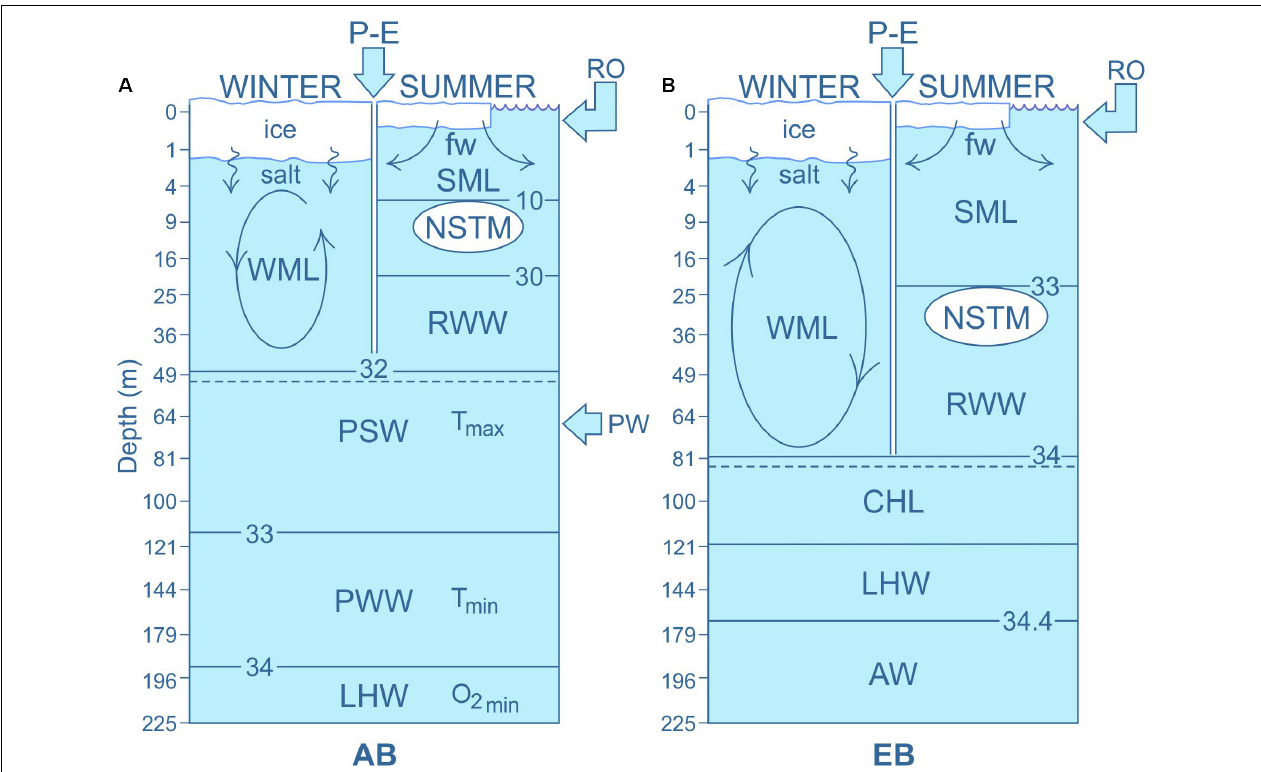
FIGURE 2 | The Arctic Ocean’s two “lids”: sea ice and the halocline. Sea ice growth in winter adds salt to the surface ocean, driving penetrative convection to form the winter mixed layer (WML). In summer, freshwater (FW) is added to the mixed layer through seasonal contributions of sea ice melt, terrestrial runoff (RO) and the balance of precipitation-evaporation (P-E), which strongly stratify the surface ocean. This stratification limits the depth of wind mixing, allowing formation of a shallow summer mixed layer (SML). Below the SML, fractions of the previous season’s processes may remain; specifically, a cool remnant winter water (RWW) immediately above the base of the WML from the previous year. In the presence of sea ice with sufficient open water, a near-surface temperature maximum (NSTM) may form immediately below the SML by solar heating, capped by the cold, low salinity surface layer. These exchanges between the surface ocean layer and the sea ice “lid” occur across the Arctic Ocean, however, the additional FW associated with Pacific water (PW) enhances surface stratification in the Amerasian Basin (AB) and contributes to the difference between the halocline “lid” within the deep AB and that of the Eurasian Basin (EB); represented conceptually in (A,B) , respectively. In both the Pacific and Atlantic sectors of the Arctic Ocean, warm Atlantic-derived waters (AW) form the base of the halocline. The water column above is comprised of multiple layers that define the seasonal and permanent haloclines, constrained by the horizontal interleaving of seasonally modified FW inputs. (A) In the Pacific sector halocline, PW inputs from the Bering Sea interflow, increasing stratification, and further constraining the depth of convection. Here, the winter convection penetrates down to the base of the Pacific Summer Water (PSW) and the sub-surface temperature maximum (Tmax), which in turn lies above the Pacific Winter Water (PWW) and the sub-surface temperature minimum (Tmin). Below PW lies lower halocline water (LHW), which likely forms on Siberian shelves. (B) In the Atlantic sector, the thickness and distribution of halocline layers is highly variable across the EB, but includes a cold halocline layer (CHL) and LHW layer above the warm AW layer. Both form as a consequence of sea ice formation and winter convective mixing events; CHL mostly within the basin and LHW on mostly on shelves with subsequent drainage into the basins (after Aagaard et al., 1981; Rudels et al., 1996; Steele and Boyd, 1998; Polyakov et al., 2013; Carmack et al., 2015a; Peralta-Ferriz and Woodgate,